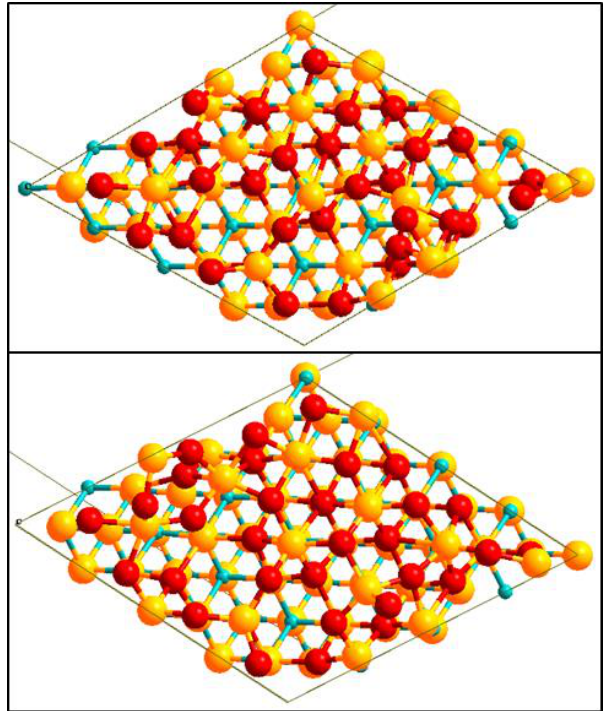
Figure 3 . The high-temperature structure after 20 ps (top) and low temperature, T = 500 K (bottom) from MD simulation. The global effect of the temperature reduction is an increase in the symmetry of the ZrO 2 layer. Yellow (Zr), light blue (C), and red (O).